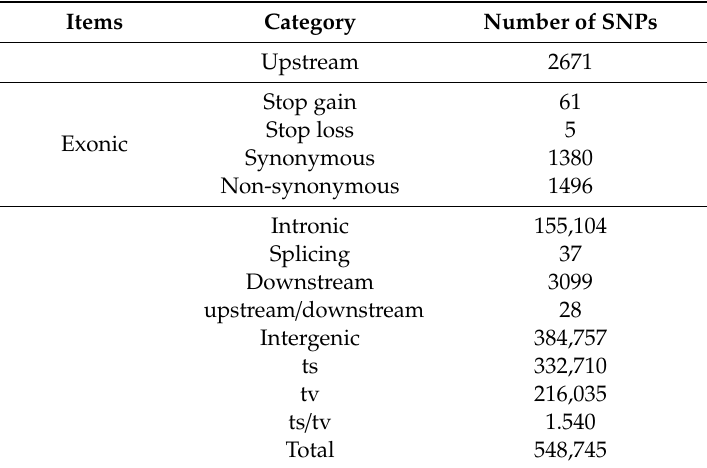
Table 2. SNP statistics and annotation